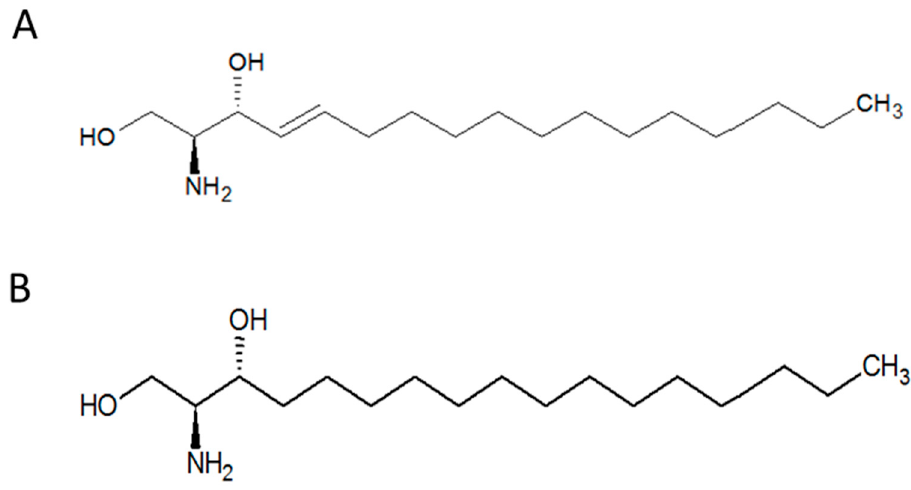
Figure 1. Structure of sphingosine ( A ) and sphinganine ( B ) .